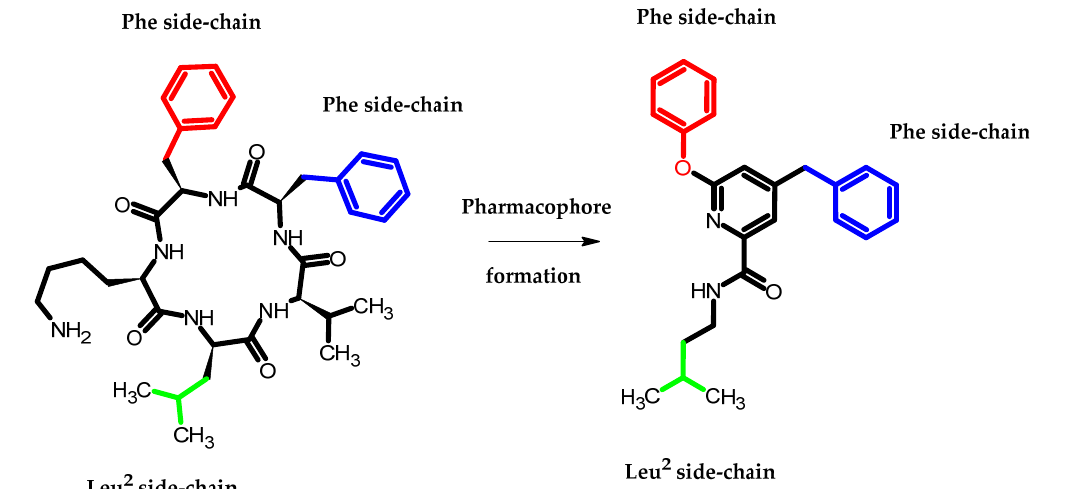
Figure 13. Schematic representation of the developed pharmacophore model in which the terminal phenoxy group plays the role of mimicking the phenylalanine side chain.